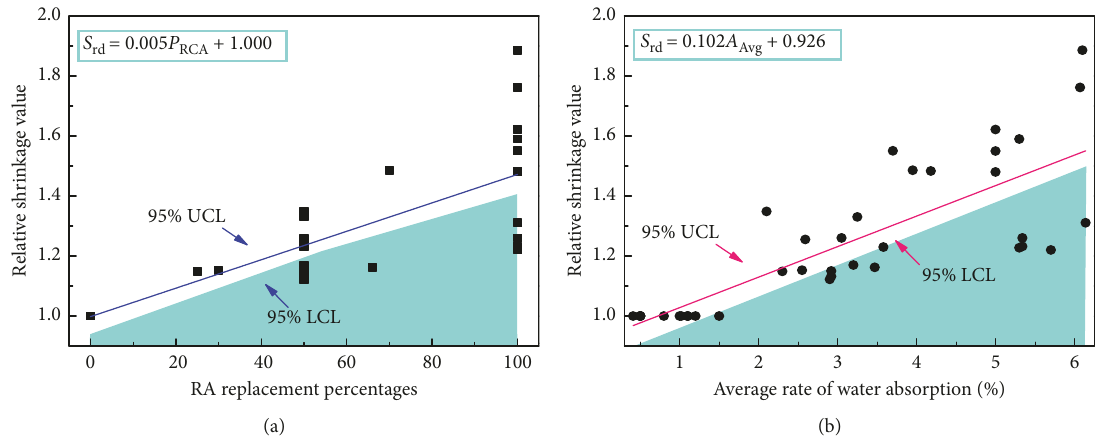
Figure 3: Shrinkage behavior of concrete with (a) various RA contents and (b) various water absorption rates [57–70].